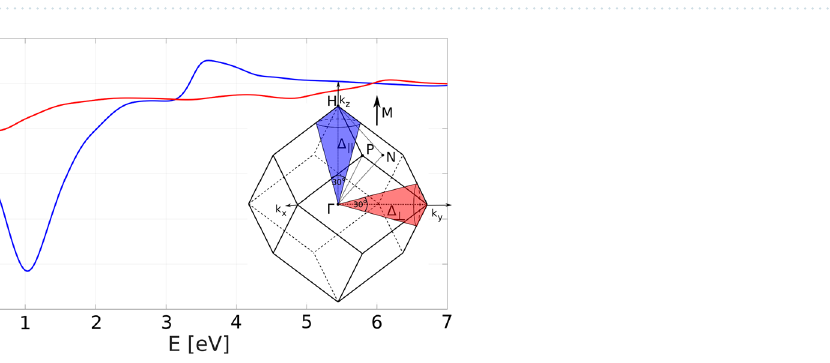
Figure 7. Local MO spectra in equally-sized cubes centered at ( a ) C (cid:31) (cid:31) , ( b ) C (cid:31) , ( c ) C (cid:31) ⊥ , and ( d ) C (cid:31) ⊥ demonstrating the classification of the MO transitions. Magnetization is in the z -direction. Black lines represent the totals. In ( a ) the contributions are dominated by 1D transitions that are spread in energy and cancel out, while in ( b ) the MO spectrum is dominated by 2D transitions that exhibit as opposite peaks with an energy offset and the cancellation is only partial. Furthermore, both ( a ) and ( b ) are classified as parallel contributions displaying much larger MO response than perpendicular contributions shown in ( c ) and ( d ).